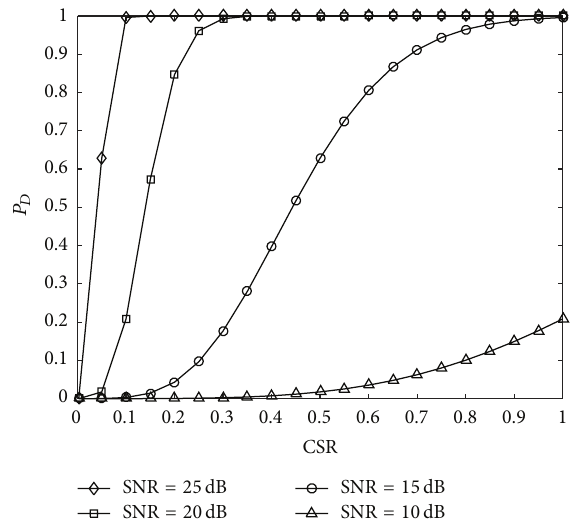
Figure 4: Effect of compressive ratio on detection performance of compressive GLRT